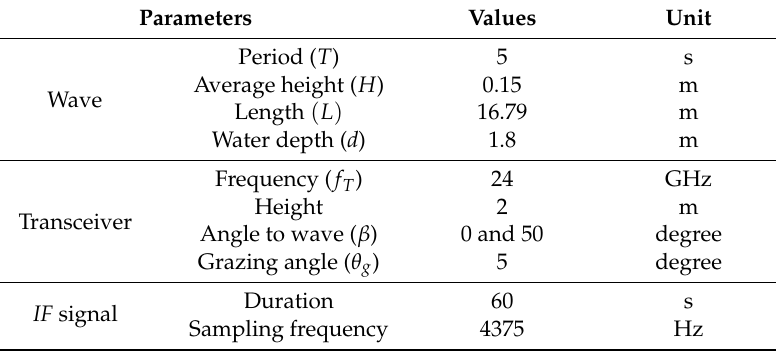
Figure 22. Wave profile in the wave tank. The horizontal straight line at 0 m is assumed to be still water level. The values on the curve are the water surface elevations measured by wave sensor. Average wave height is 0.15 m; wave period is 5 s; wave length is 16.79 m which is measured with two separate wave sensors mounted along the propagation direction of the wave. Table 7. Validation experiment configurations.